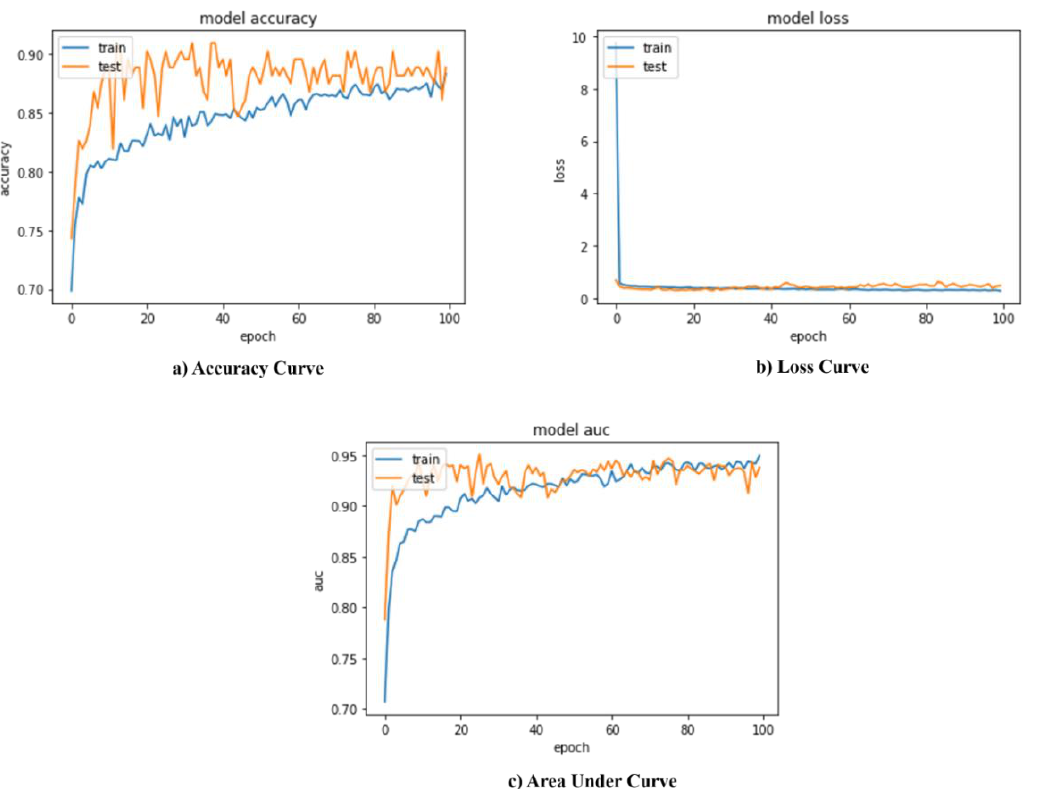
Figure 4. Performance evaluation metrics of proposed model normal/abnormal classification. a ) Accuracy Curve, b ) Loss Curve and c ) Area Under Curve.